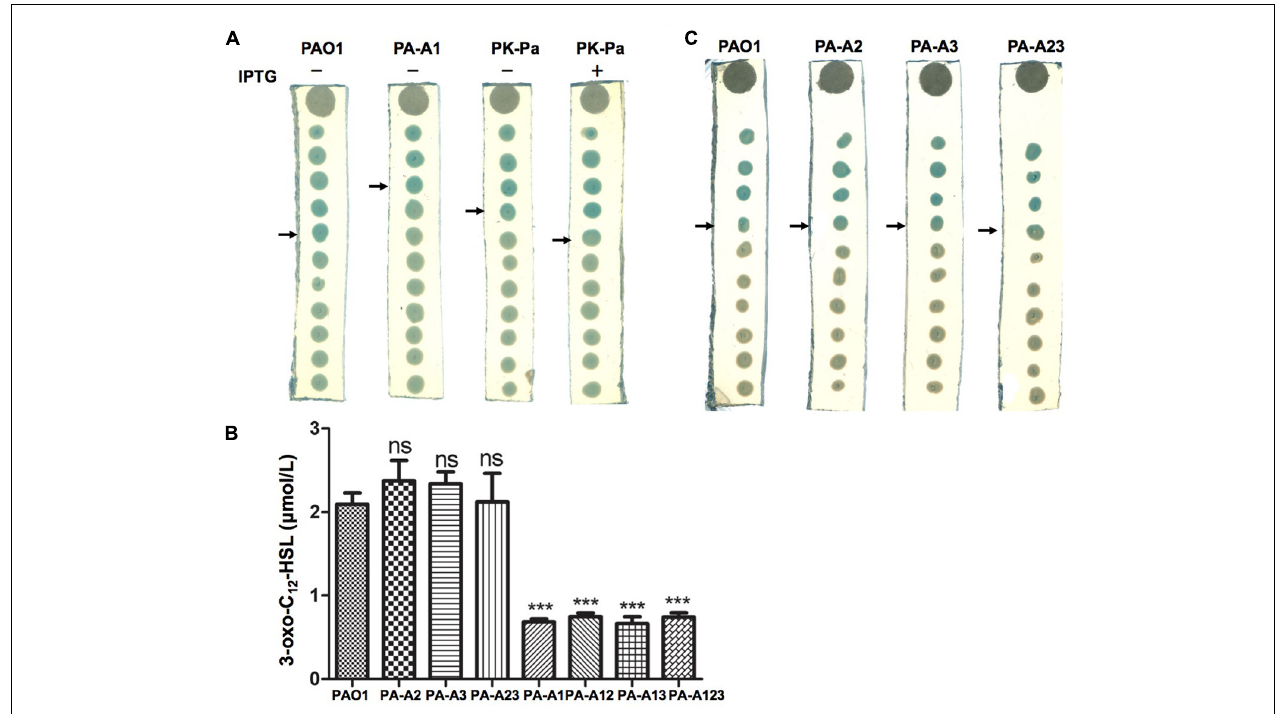
FIGURE 3 | Detection of 3-oxo-C 12 -HSL signals produced by P. aeruginosa mutant strains. (A) Analysis of the 3-oxo-C 12 -HSL signals produced by P. aeruginosa acpP1 mutant strains using Agrobacterium tumefaciens reporter strain NTL4 (pZLR4). (B) Quantitative analysis of the 3-oxo-C 12 -HSL signals produced by P. aeruginosa acpPs mutant strains using high performance liquid chromatography (HPLC). (C) Analysis of the 3-oxo-C 12 -HSL signals produced by P. aeruginosa acpP2 and acpP3 mutant strains using A. tumefaciens reporter strain NTL4 (pZLR4). The acylated HSL fraction was extracted from the supernatants of stationary-phase cultures grown in LB broth at 37 ◦ C for 12 h. PAO1, P. aeruginosa wild type strain; PA-A2, P. aeruginosa acpP2 ::Gm r single mutant strain; PA-A3, P. aeruginosa acpP3 ::Gm r single mutant strain; PA-A23, P. aeruginosa acp2 ::Tc r acp3 ::Gm r double mutant strain; PA-A1, P. aeruginosa acp1 ::Ec acpP single mutant strain; PA-A12, P. aeruginosa acp1 ::Ec acpP acp2 ::Gm r double mutant strain; PA-A13, P. aeruginosa acp1 ::Ec acpP acp3 ::Gm r double mutant strain; PA-A123, P. aeruginosa acp1:: Ec acpP acp2:: Tc r acp3:: Gm r triple mutant strain; PK-Pa, P. aeruginosa acp1 ::Ec acpP single mutant strain carrying plasmid, pSRKPa, encoding wild type P. aeruginosa acpP1 gene. The arrow indicates the diffusion front of 3-oxo-C 12 -HSL. Data are the mean ± standard deviation of triplicate measurements. Pair-wise comparisons were made between wild-type strain PAO1 and each mutant strain by Student’s t -test. ∗∗∗ Highly significant difference, P < 0.01. ∗∗ Significant difference, P <